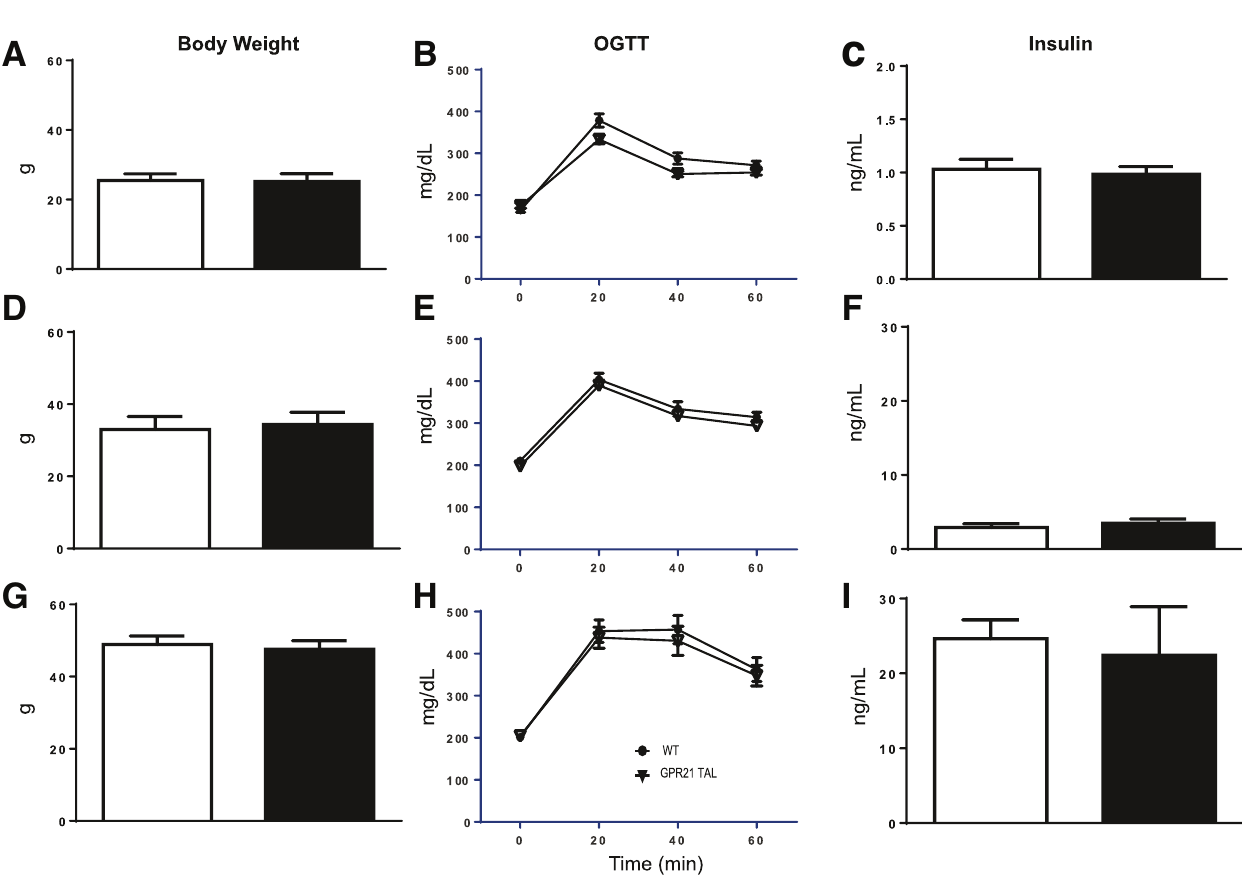
Figure 4. At 11 weeks of age, body weight (Figure 4A ), OGTT (Figure 4B ) and insulin levels (Figure 4C ) were measured in wildtype (open bar and open circle) and Gpr21 TAL 29bp KO Mice (filled bar and open triangle) fed a normal chow diet. At 15 weeks of age and at 26 weeks of age body weight (Figure 4D & 4G ), OGTT (Figure 4E & 4H ) and insulin levels (Figure 4F & 4I ) were measured in wildtype (open bar and open circle) and Gpr21 TAL 29bp KO Mice (filled bar and open triangle) fed a high fat diet for 4 weeks and 15 weeks,